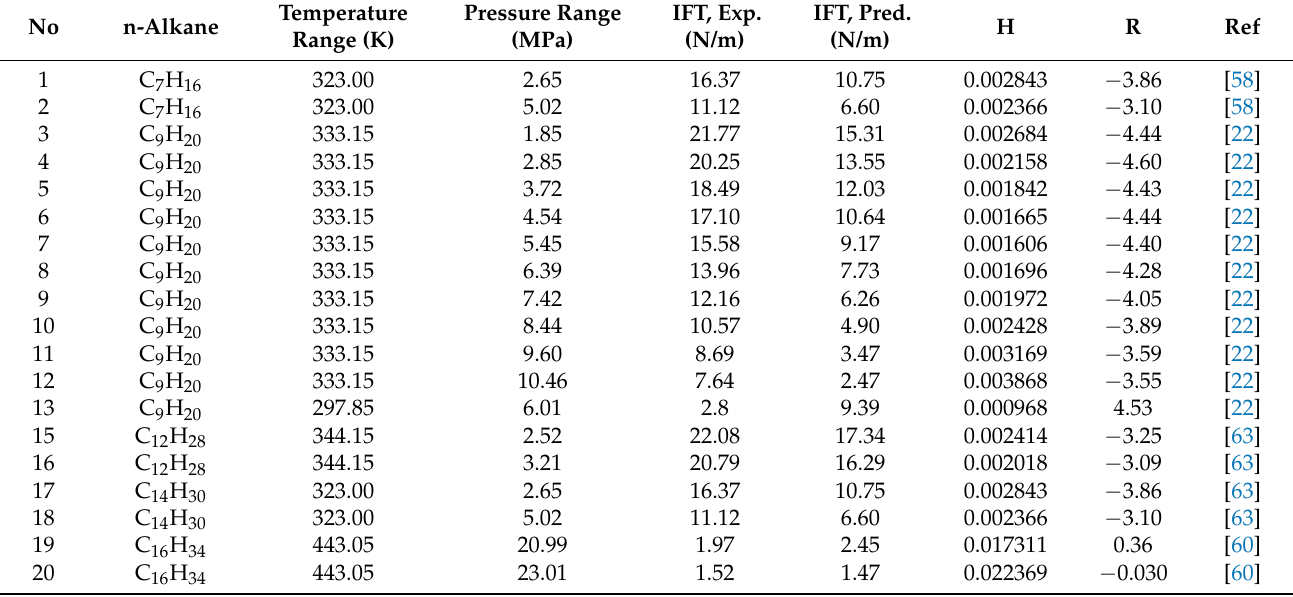
Figure 9. Determination of possible outlier data points and application area of the proposed model for IFT estimation. Table 4. List of the suspected data identified by the leverage